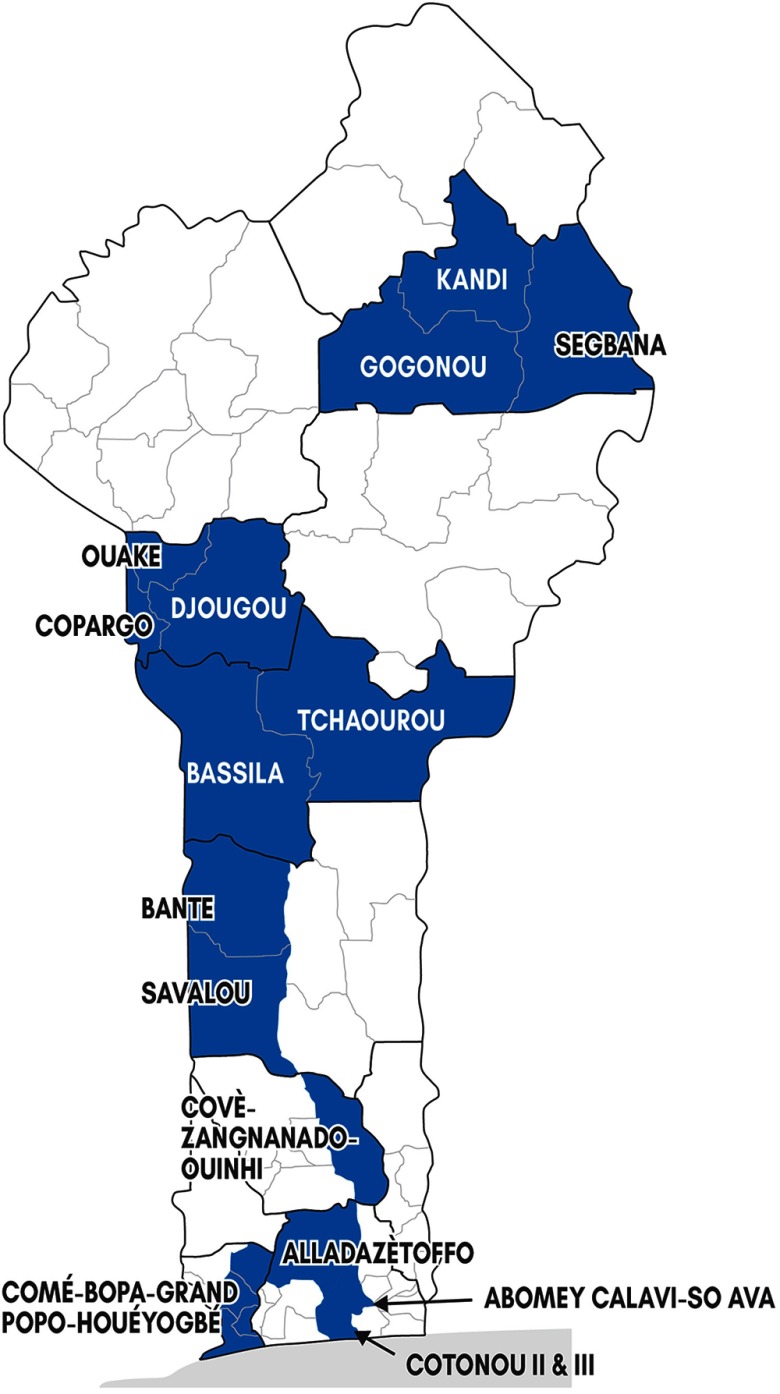
Map of DMPA-SC Introduction ZonesAbbreviation: DMPA-SC, subcutaneous depot medroxyprogesterone acetate.